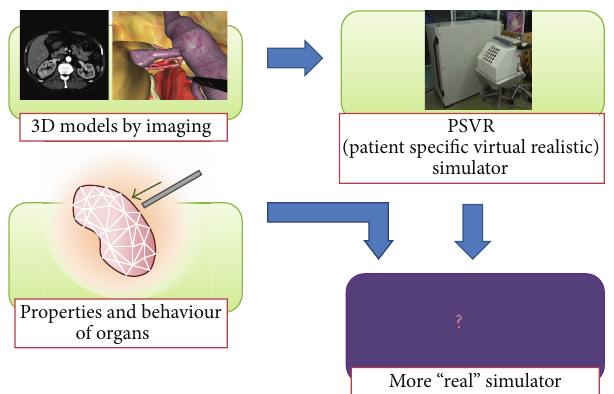
Figure 1: To make our simulator performance more “real,” we considered the importance of the subjective sensation that surgeons feel while using it.